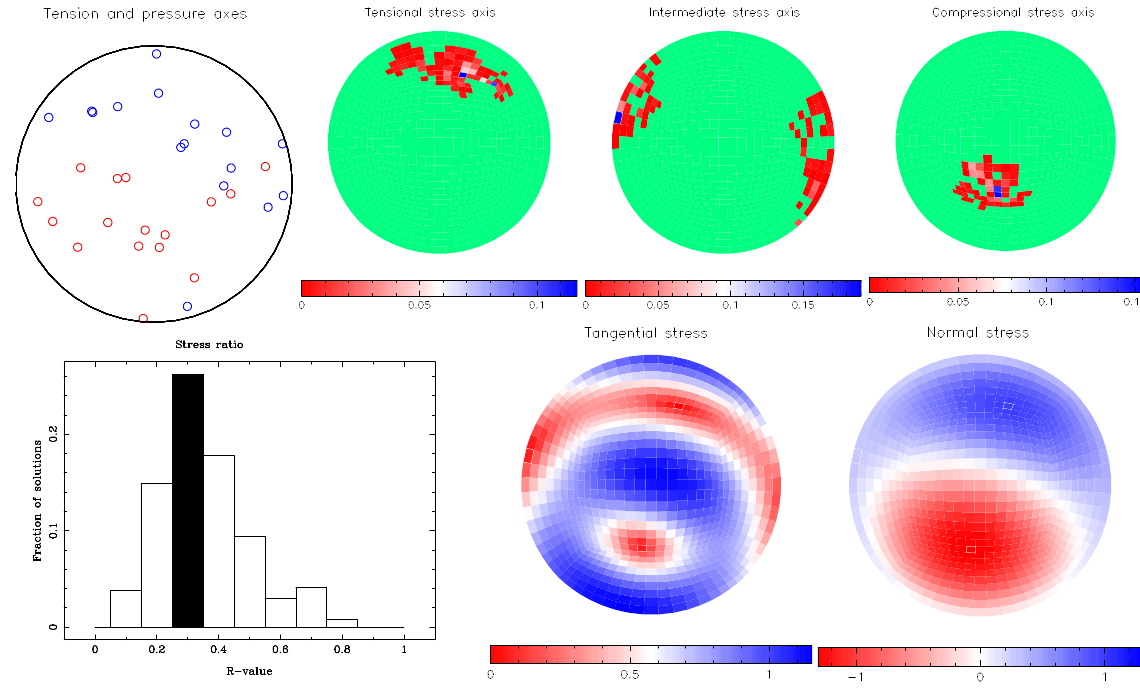
Fig. 9. Results of stress inversion for cluster of shallow earthquakes near Goekova . Explanation of subfigures in figure 5.